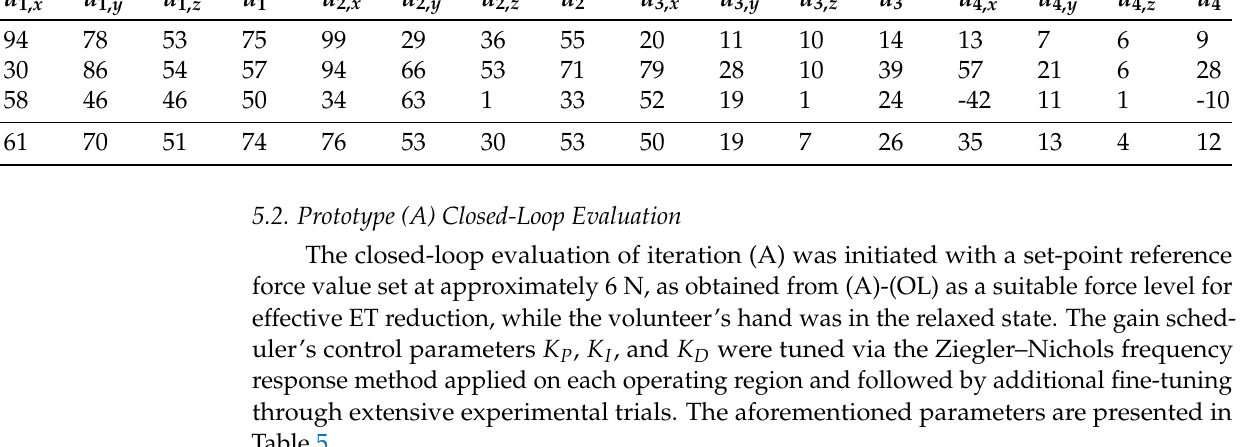
Table 4. ET amplitude reduction rates during the Prototype (A) Open-Loop evaluation. Exp.